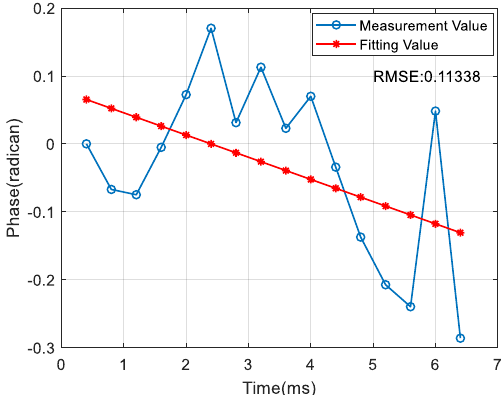
Figure 2. Phase fitting with RMSE below threshold, but not the meteor echo.